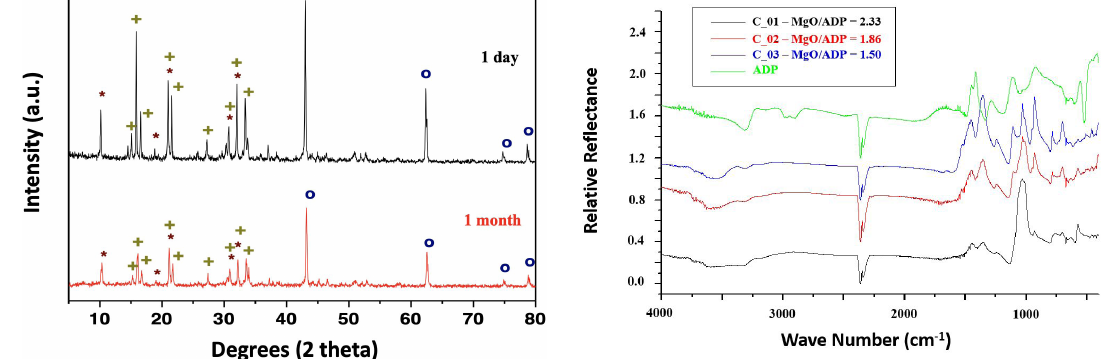
Figure 7. X-ray diffractograms of composition C_04, prepared from MgO powders calcined at 1100 °C / 2 h, with different ages, after setting (Phases: + struvite; * dittmarite; o MgO).